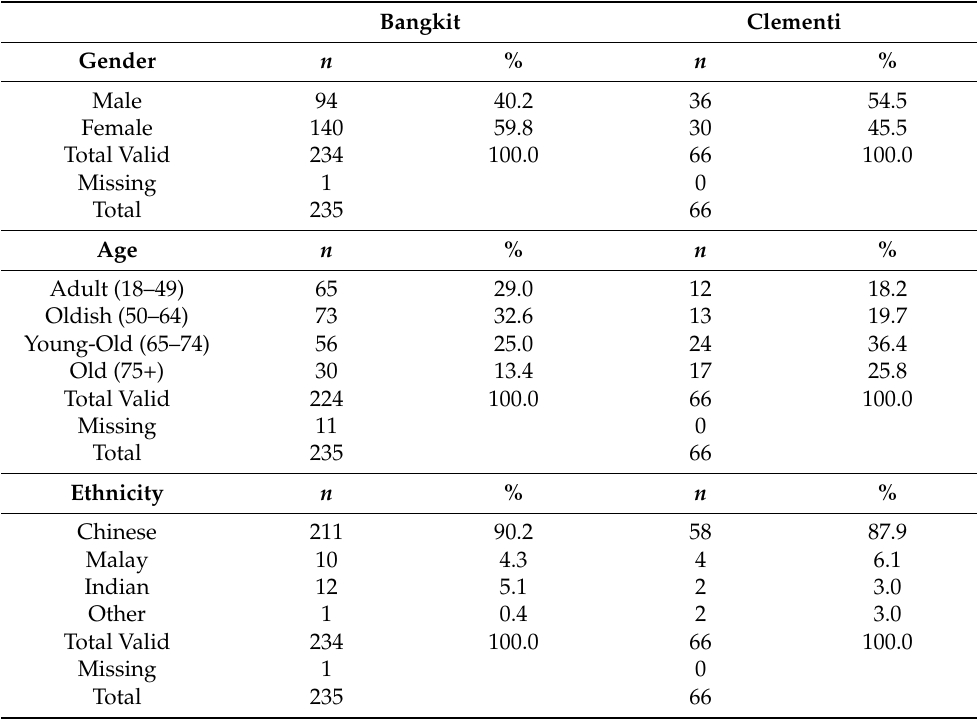
Table 1. Survey sample: gender, age and ethnicity profiles. Bangkit